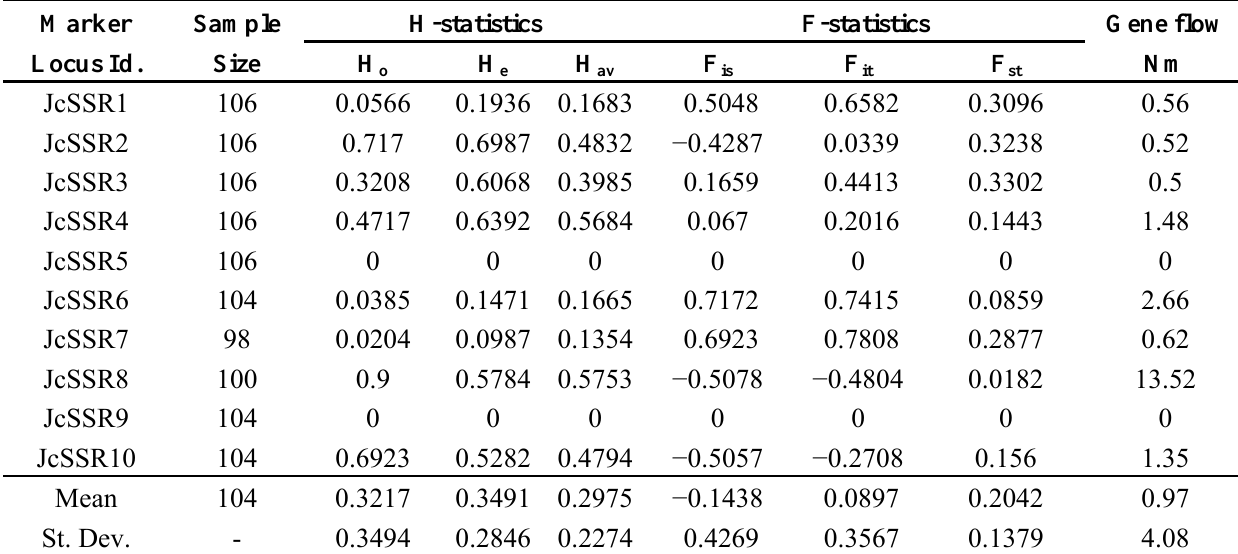
), expected heterozygosity (H ) o e ), whereas Wright’s inbreeding coefficients F and F were av is it is the degree st